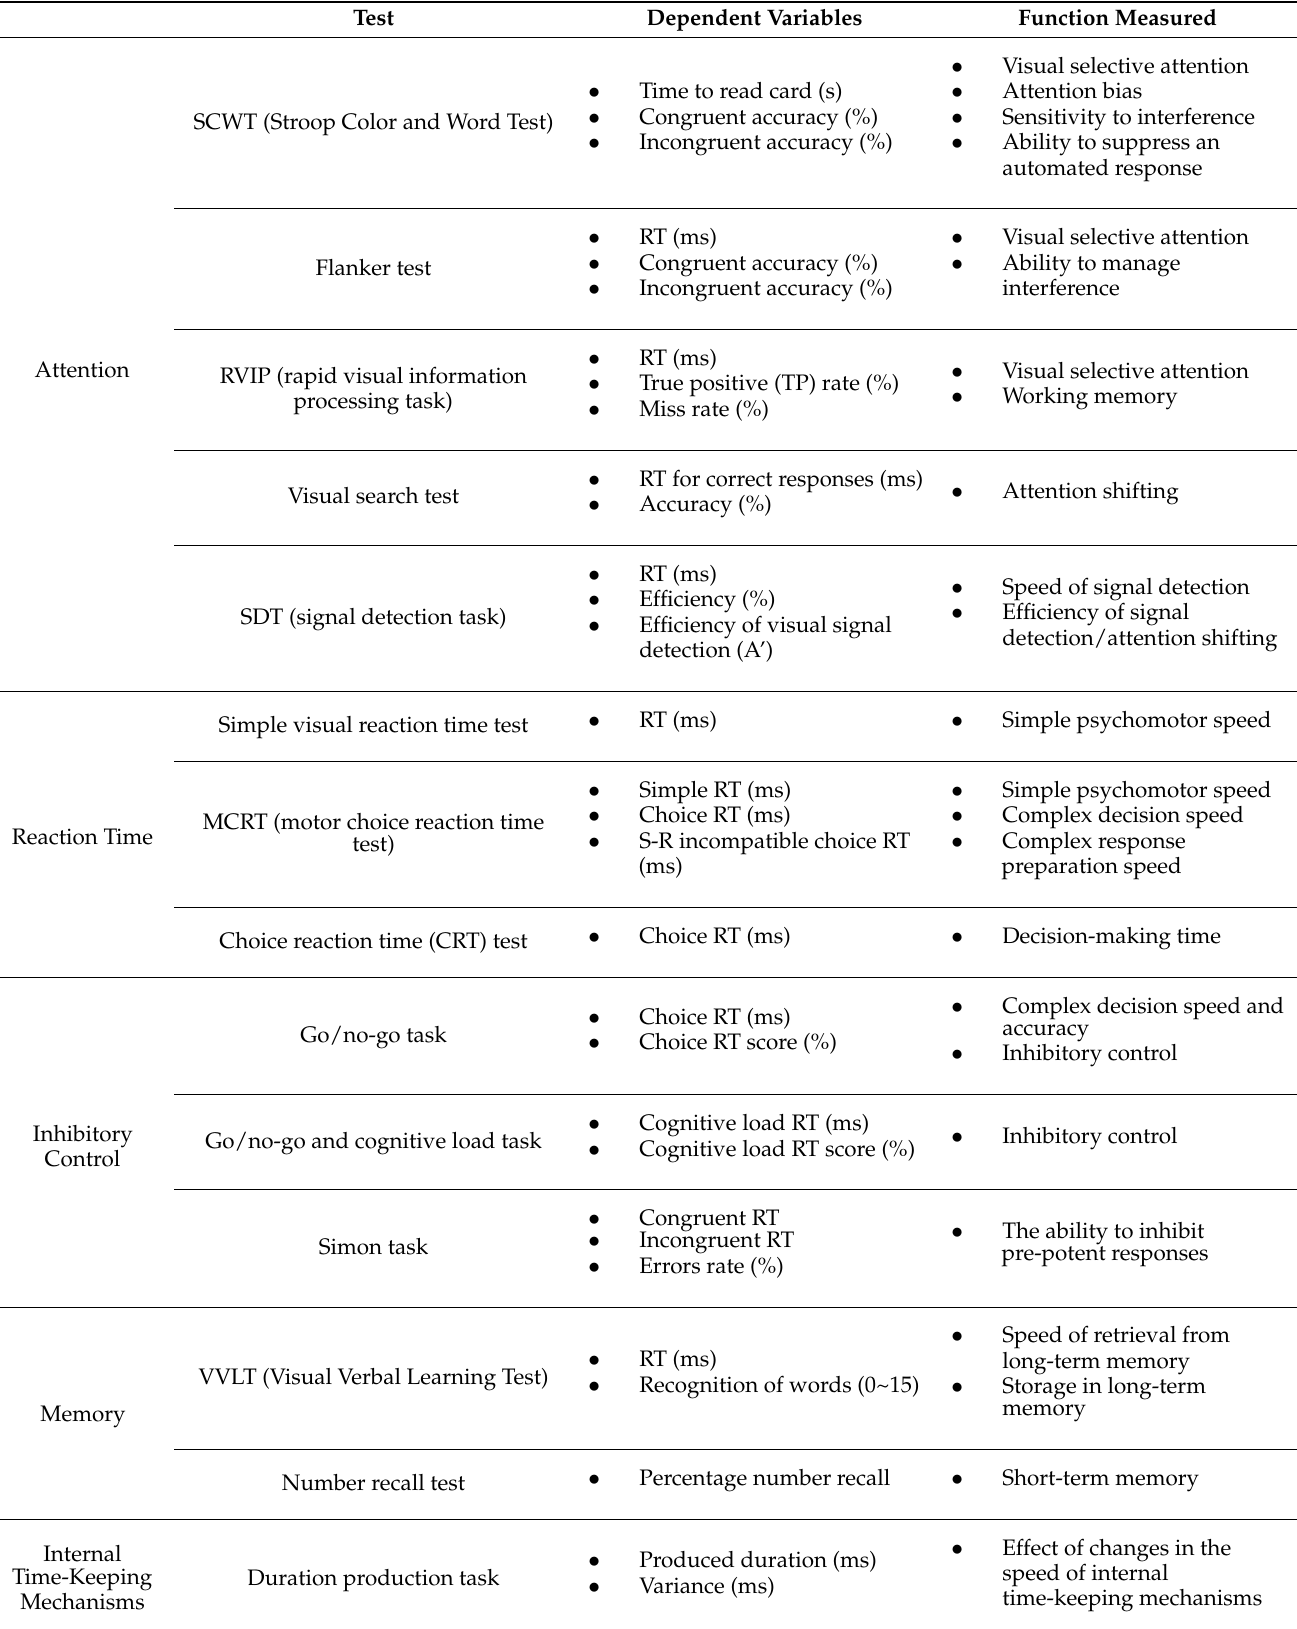
Table 3. Objective tests, dependent variables, and cognitive functions